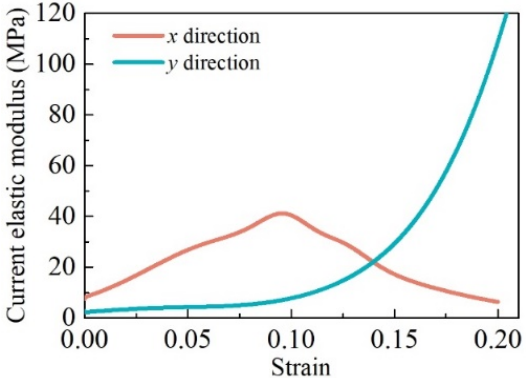
Figure 3. Difference in current elastic modulus in x and y –directions.